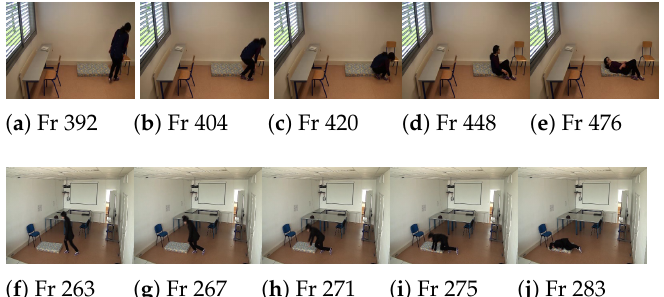
Figure 7. Illustration of posture transition frames of fall activity and normal lying activity. Frames ( a – e ) present a sequence of the lying activity. The lying activity starts from frame number Fr404 ( a ) and ends to frame number Fr476 ( e ). Frames ( f – j ) present sequence of the fall activity. The fall activity starts from frame number Fr263 ( f ) and endqws to frame number Fr283 ( j